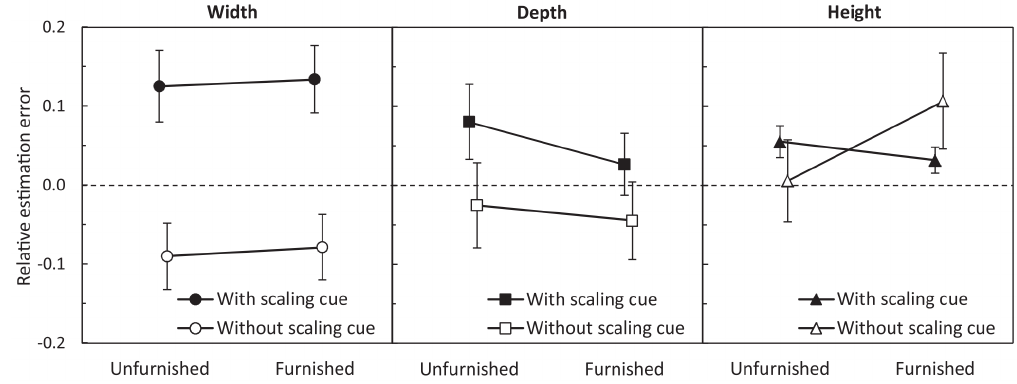
Figure 4. Experiment 1: Mean relative estimation errors of the three room dimensions as a function of furnishing and scaling cue. Error bars show 6 1 SEM of the 39 individuals in the factor level combinations with scaling cue and of the 40 individuals in the factor level combinations without scaling cue.